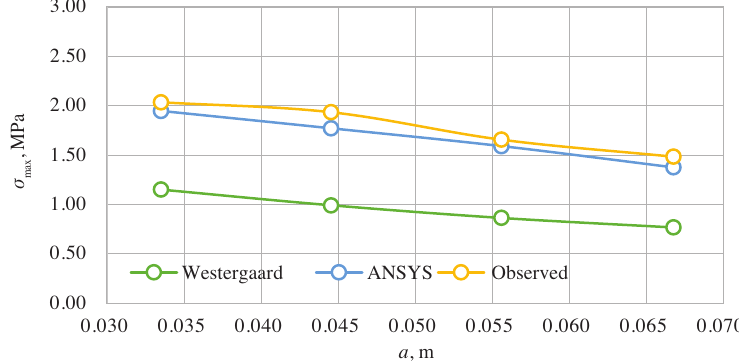
Figure 11. Variation of load area radius ( h = 3.38 cm and load at the